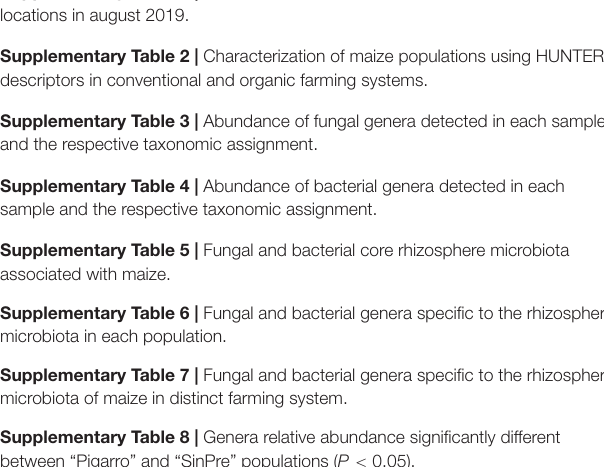
Supplementary Table 1 | Soil characterization of the trial locations in august